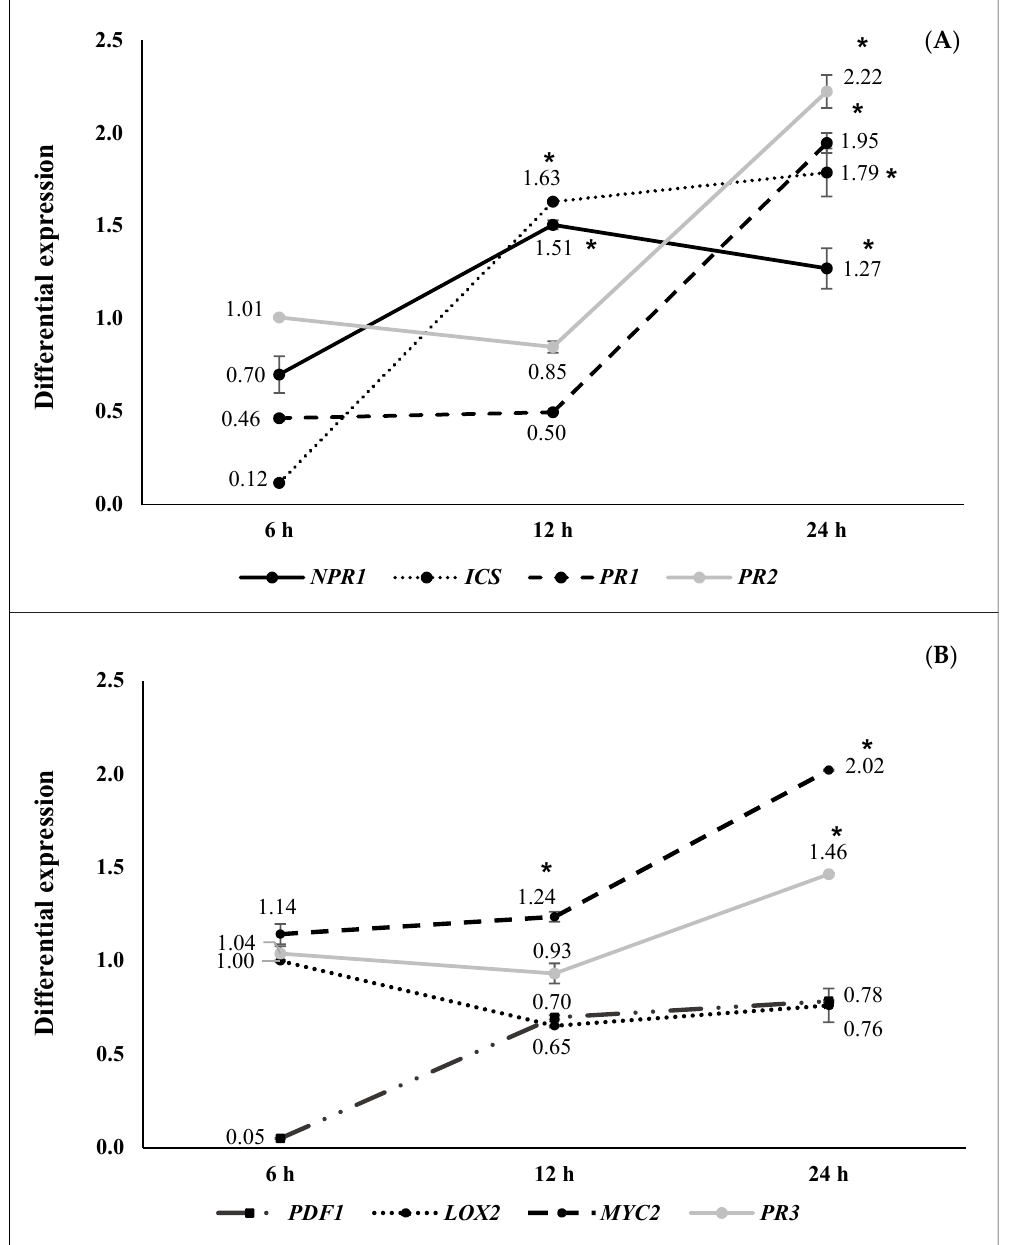
Figure 3. Differential gene expression (seedlings inoculated with N 8.17 ( Stenotrophomonas maltophilia ) vs negative control) at 6 ( n = 16), 12 ( n = 16), and 24 ( n = 16) hapc; ( A ) NPR1 , ICS , PR1, and PR2 genes (as SA signaling pathway markers) and ( B ) PDF1 , LOX2 , MYC2, and PR3 (as JA/ET signaling pathway markers). Asterisks represent statistically significant differences ( p < 0.05) with respect to negative control (differential expression of 1).